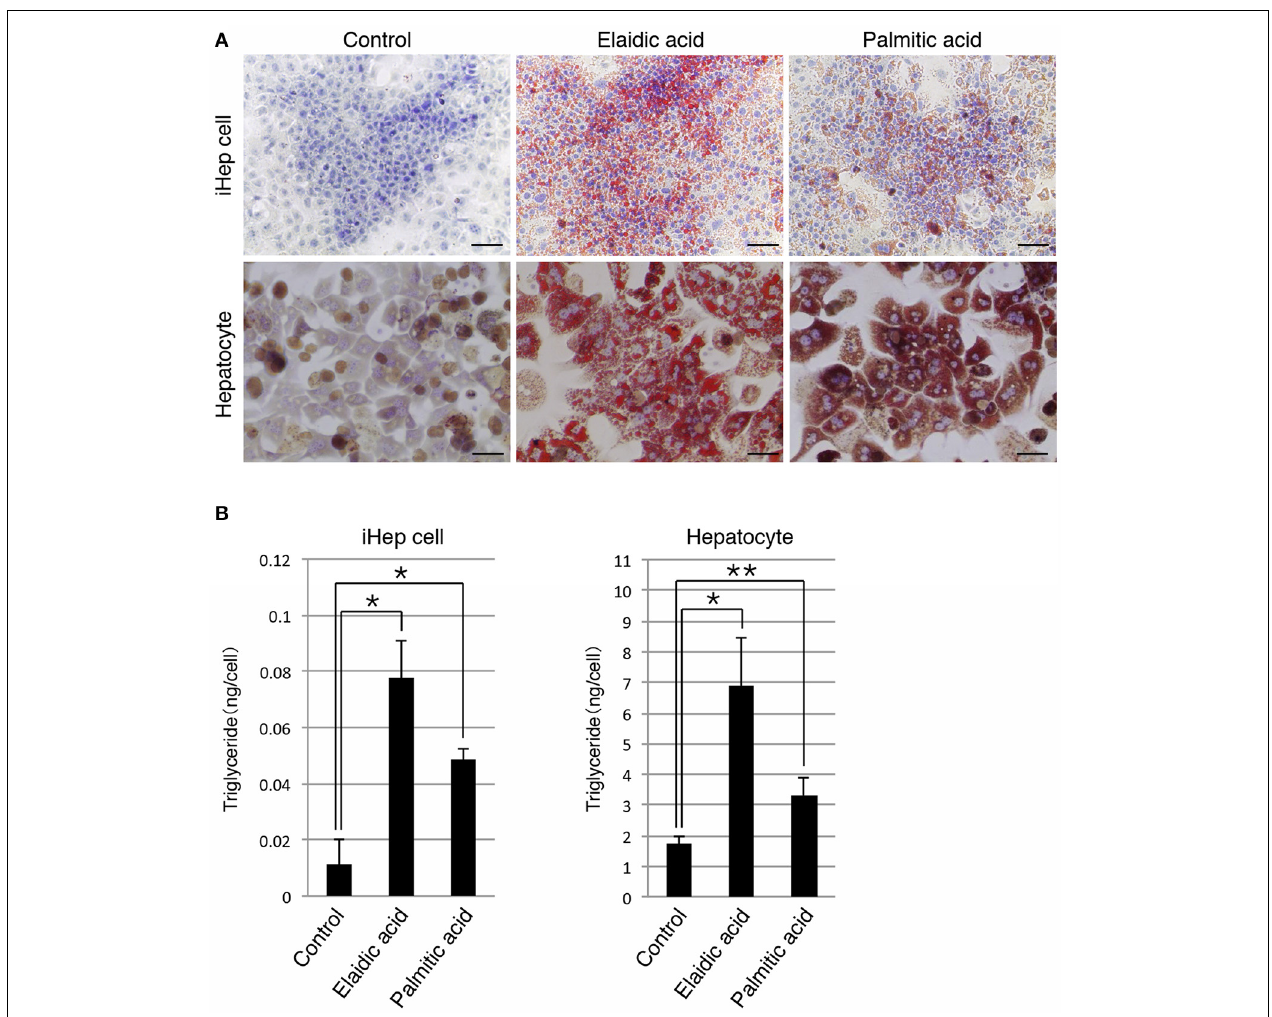
FIGURE 2 | iHep cells are capable of synthesizing lipids from a trans-unsaturated fatty acid and a saturated fatty acid. (A) Oil red O staining was conducted for iHep cells and primary hepatocytes cultured with elaidic acid, a trans-unsaturated fatty acid, or palmitic acid, a saturated fatty acid, and without any fatty acids (control). DNA was stained with